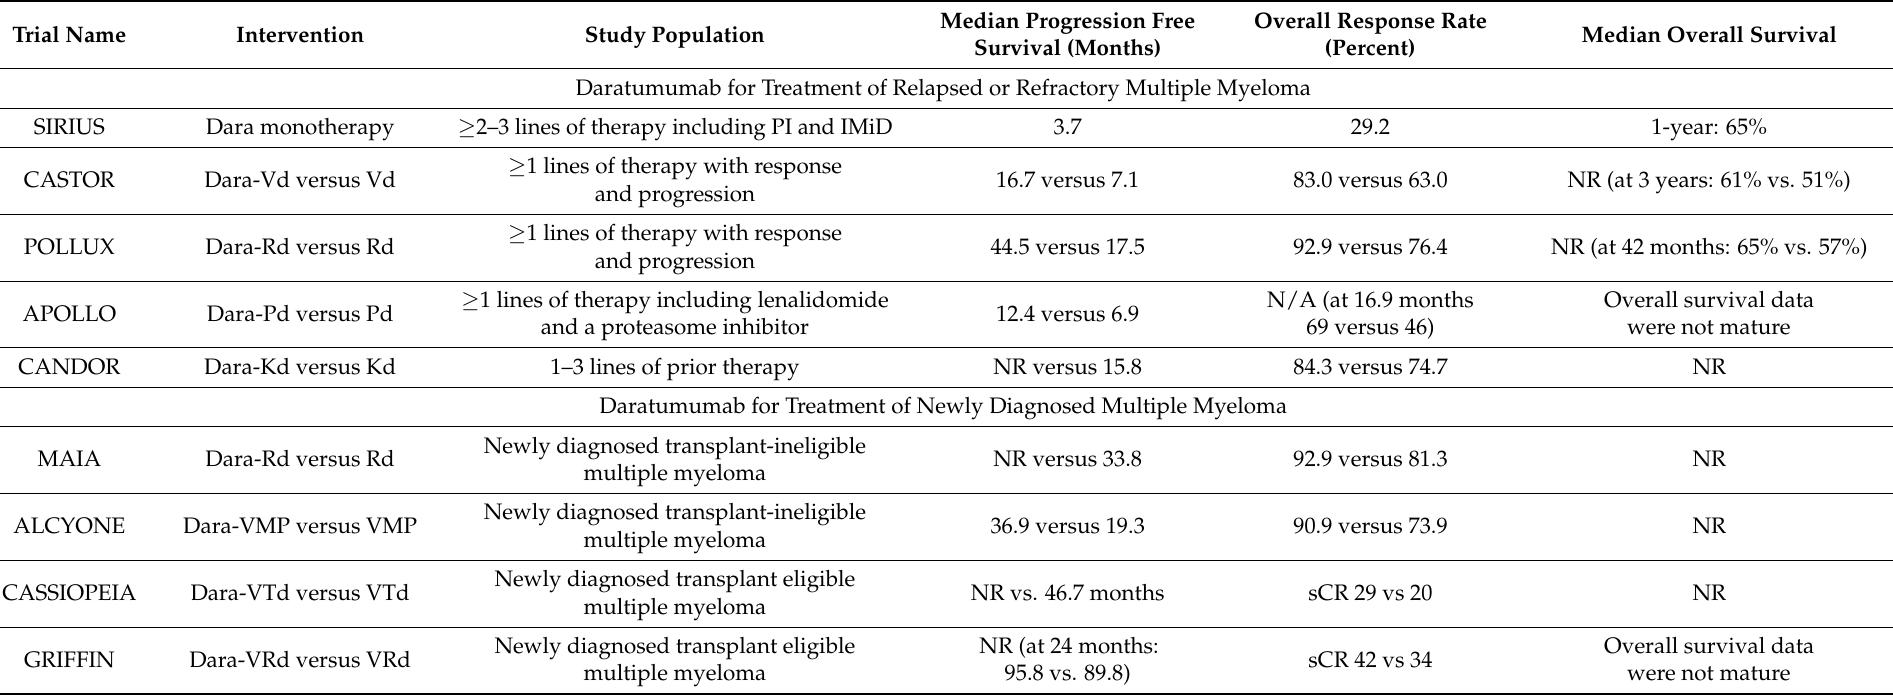
Table 3. Summary of Major Clinical Trials Leading to FDA Approval of